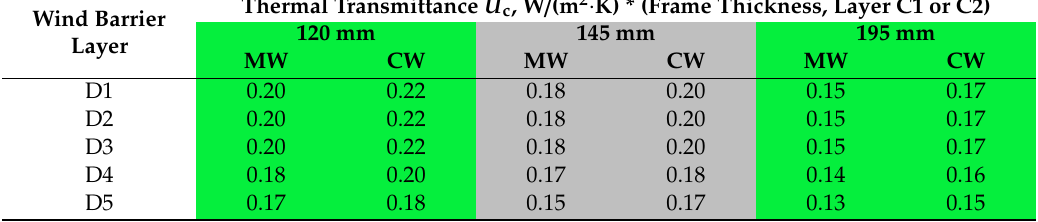
Table 2. Thermal transmittance U c (W/(m 2 ·K)) * of analyzed sets with different insulation materials (mineral wool (MW) and cellulose wool (CW)) and wind barrier layers. See Table 1 for description of layers D1–D5.